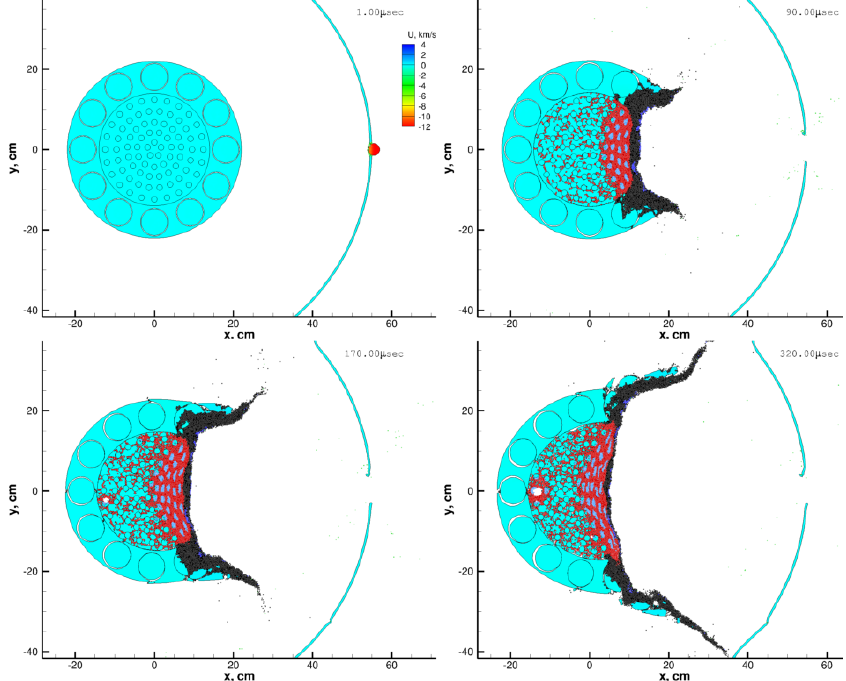
Figure 12: Photographic records of the impact of space debris with a reactor equipped with the Whipple shield.